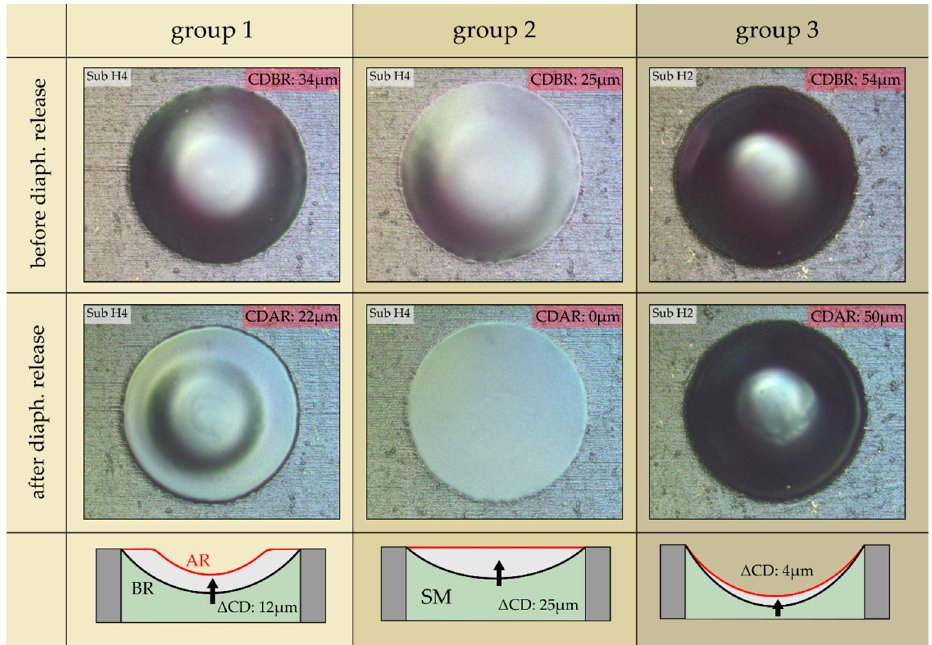
Figure 10. Optical microscope images of typical diaphragms of the three groups before (first row) and after (second row) they are released from the SM. The corresponding curvature depth is indicated with a red tag in the images. The bottom row shows schematic illustrations of the diaphragm profile geometry of each group before (BR) and after release (AR). Dimensions do not scale.